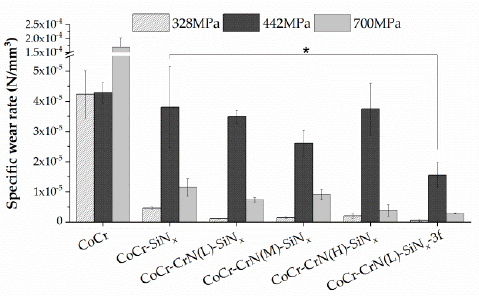
Figure 4. Specific wear rates at 328 and 442 MPa, ran against a 20 mm Si 3 N 4 ball, as well as at 700 MPa with 10 mm ball. * Statistically significant difference.